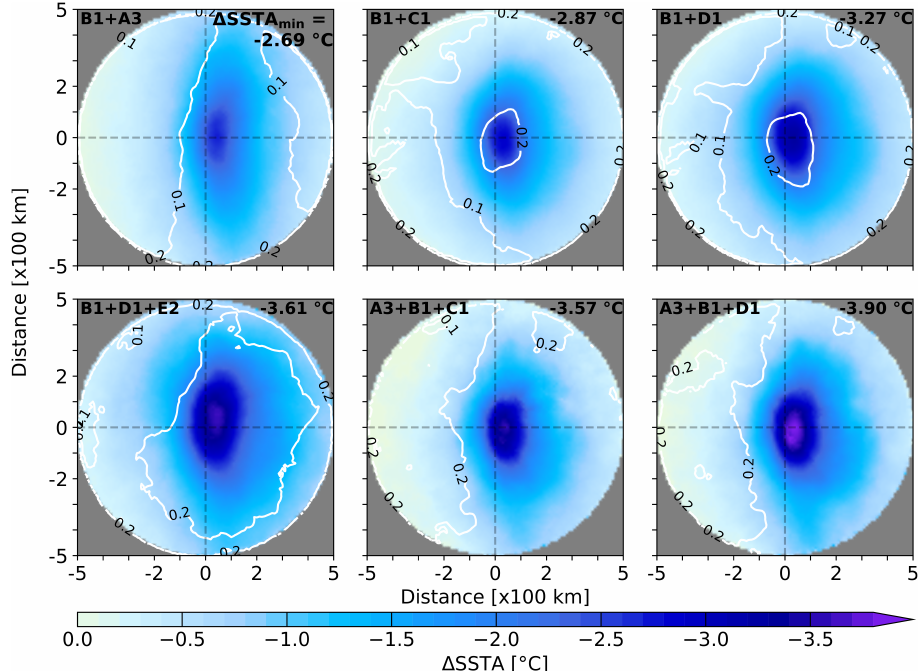
Figure 9. Mean composites of ∆ SSTA based on the merged SST dataset for the following combination of two (top row) and three (bottom row) parameters. Top row from left to right panels: (B1+A3), (B1+C1) and (B1+D1); Bottom row from left to right panels: (B1+D1+E2), (A3+B1+C1) and (A3+B1+D1). White contours represent the margin of error of ∆ SSTA. More information is provided in Table